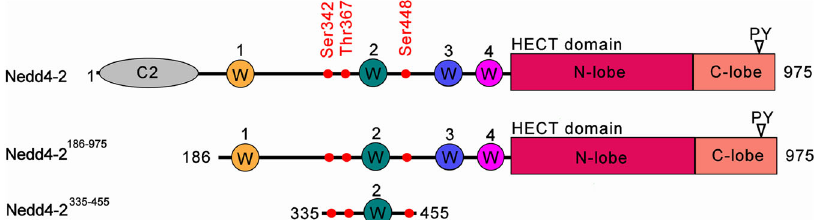
Fig. 1 Domain structure of human Nedd4-2 and the expression constructs used in this study. On the top, a schematic representation of the Nedd4-2 domain structure shows the relative positions of sites phosphorylated by PKA in vitro in red dots. Ser 342 , Thr 367 and Ser 448 are 14-3-3 binding motifs. The Ca 2 + /lipid binding domain is shown in grey (denoted as C2), and the WW domains 1-4 (denoted as W) are shown in yellow, teal, blue and magenta. The HECT domain N- and C-lobes are shown in raspberry and salmon, respectively. The boundaries of two constructs used in this study are Nedd4-2 186 – 975 and Nedd4-2 335 – 455